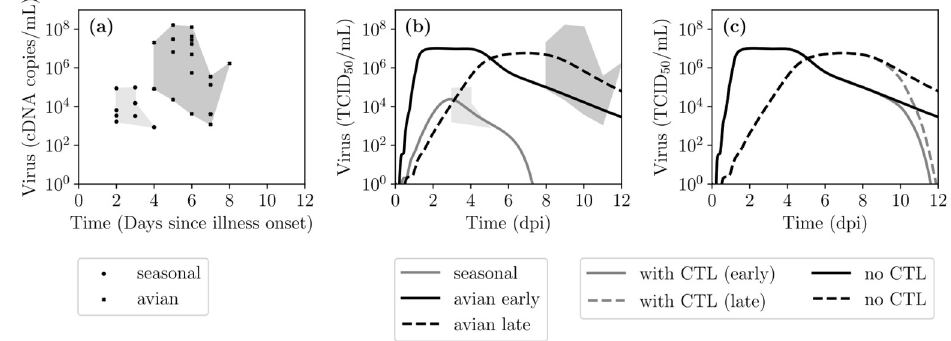
Fig 11. Kinetics of infection in patients naturally infected with a seasonal or avian IAV strain. (a) Total viral load measurements (cDNA/mL via qRT-PCR) from throat (pharyngeal) swabs of patients which naturally contracted infections with either a seasonal (H3N2 or H1N1) or avian (H5N1) IAV strain (data taken from [59]). The shaded polygons trace out the extent of the data points. (b) Proposed time courses for in vivo IAV infections with either a seasonal (grey) or H5N1 (black) IAV strain. The solid and dashed black lines represent two plausible time courses for infection with an IAV H5N1 strain: a more rapid rise to higher viral titers than for infections with seasonal strains (solid); or a more moderate rise, similar to that seen for infections with seasonal strains, that grows to higher titer due to lack of rapid and effective immune control (dashed). MM parameters for these curves are listed in Table 2. (c) The possible effect of a delayed CTL response, i.e. one which peaks at 12dpi with a killing efficacy of k both the early (solid) and late (dashed) infection time courses which are otherwise shown without a CTL response